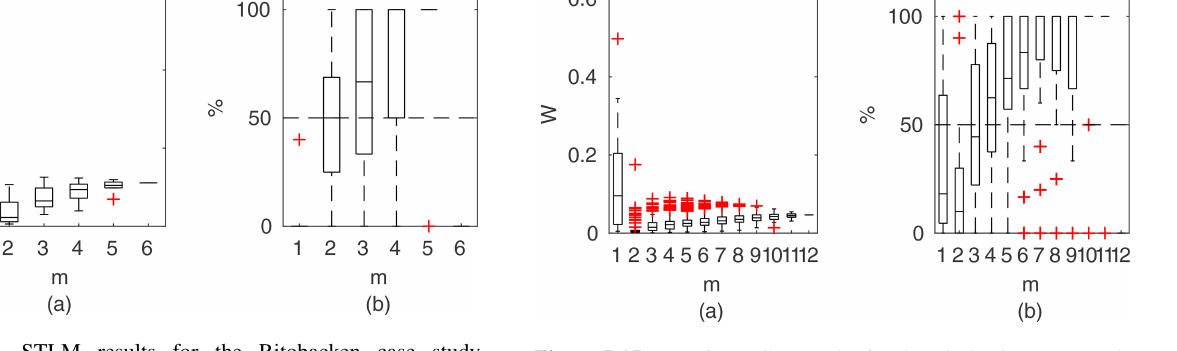
Figure B15. Manning DCM results for the Ritobacken case study, autumn 2011: (a) averaged relative confidence widths W as a func- tion of observation set size m used for model identification; (b) per- centage of verification points enclosed by the confidence inter- vals (100% denotes all points within intervals, box spans over the 25% and 75% quantiles, the median is given with horizontal line, whiskers indicate the result extent, and cross marks are for extreme values).